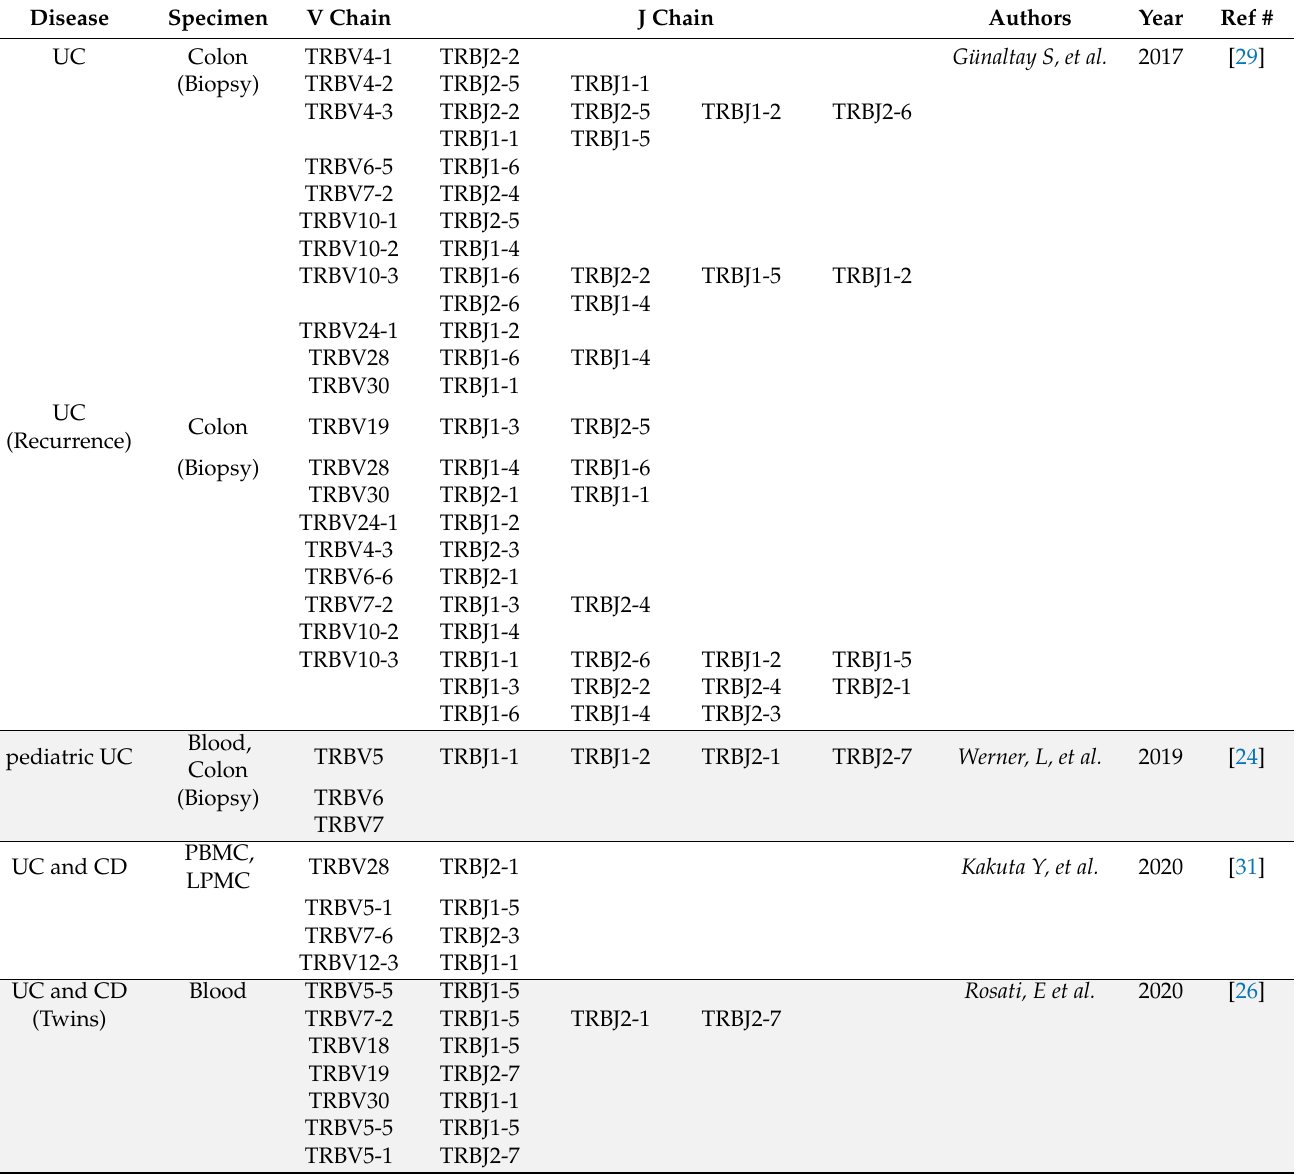
Table 1. Summary of TCR β usage studies in human